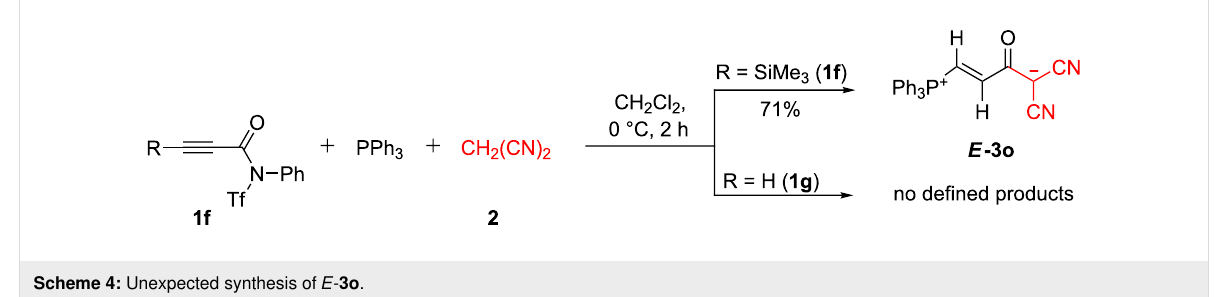
Scheme 4: Unexpected synthesis of E - 3o .